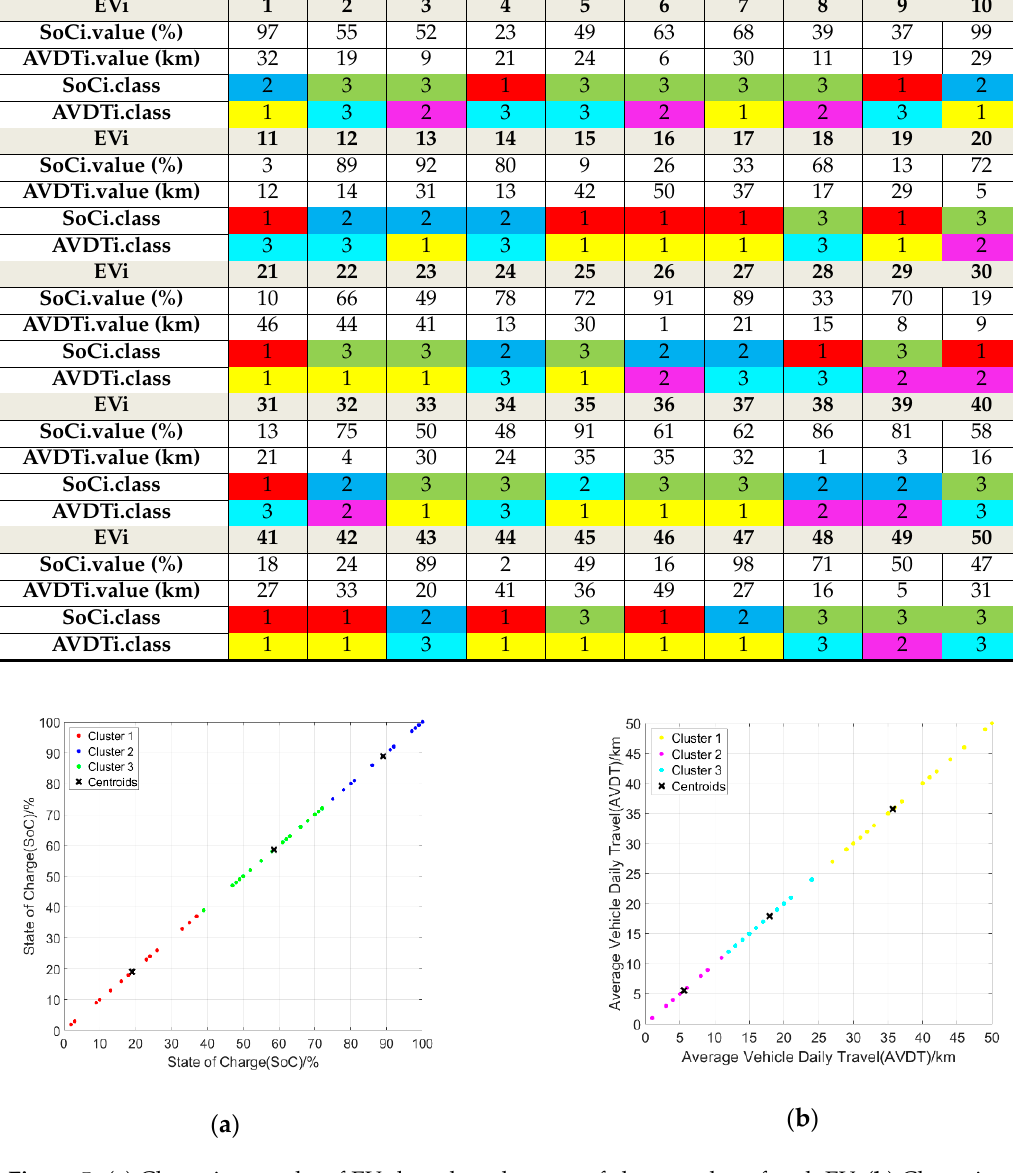
Figure 5. ( a ) Clustering results of EVs based on the state of charge value of each EV; ( b ) Clustering results of EVs based on the average vehicle daily travel value of each EV.